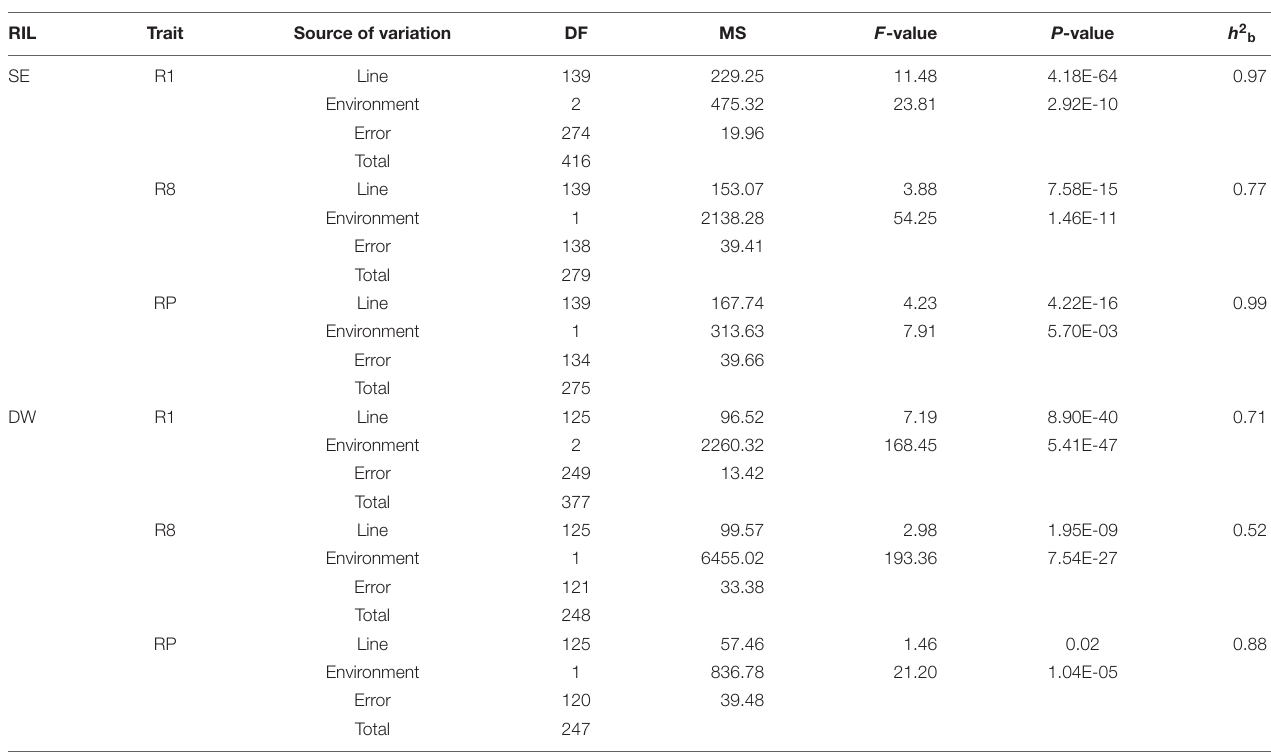
TABLE 3 | Analysis of variance for three traits of two RILs in different